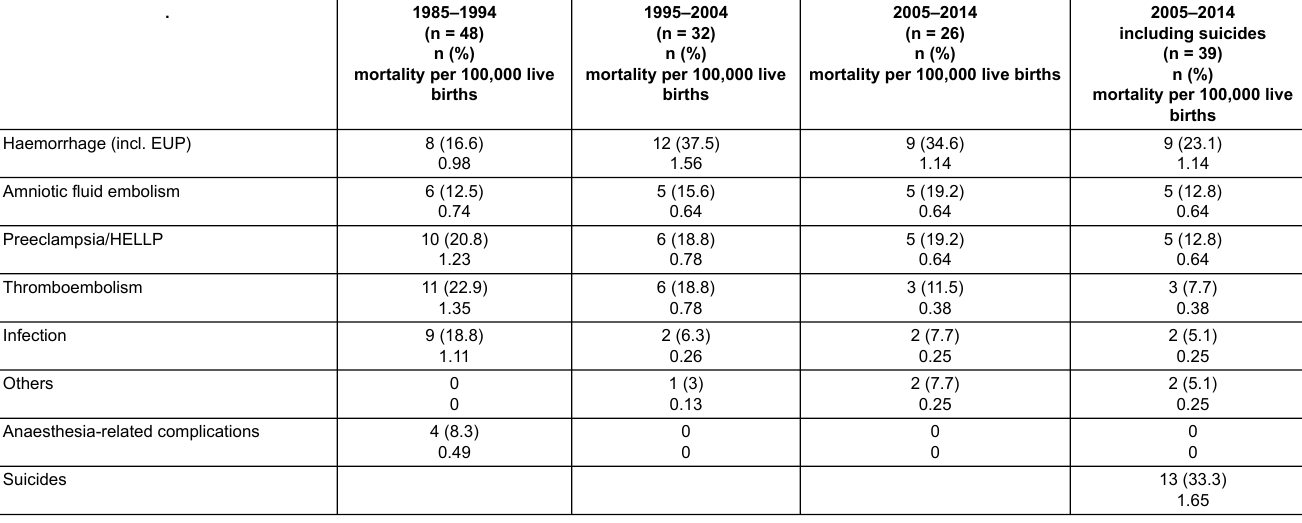
Table 4: Direct maternal mortality in Switzerland 1985–2014.